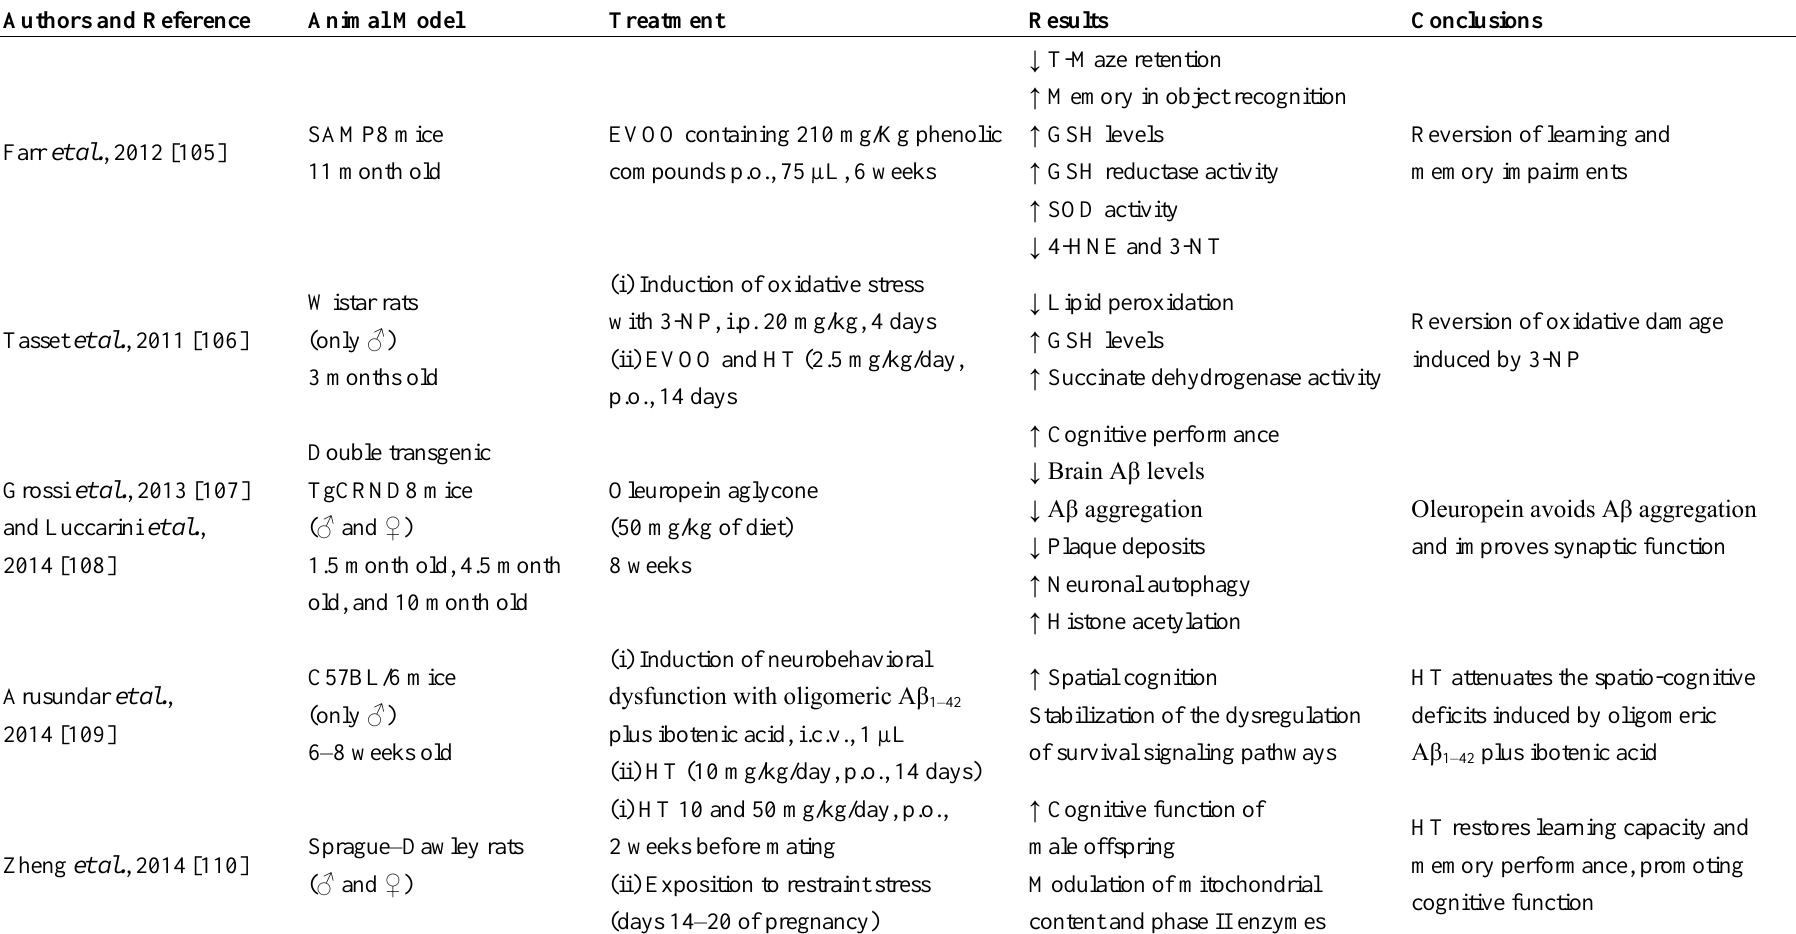
Table 2. In vivo studies related to hydroxytyrosol (HT) neuroprotective